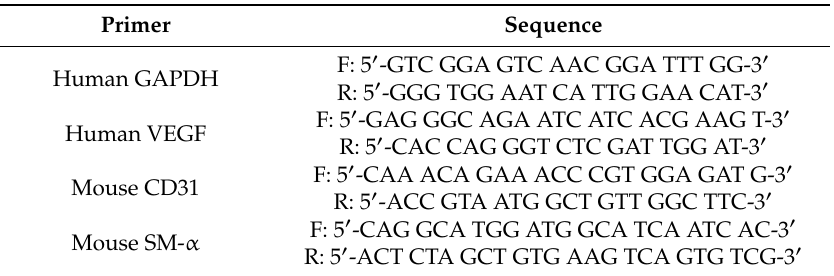
Table 1. Sequences for primers used in qRT-PCR.